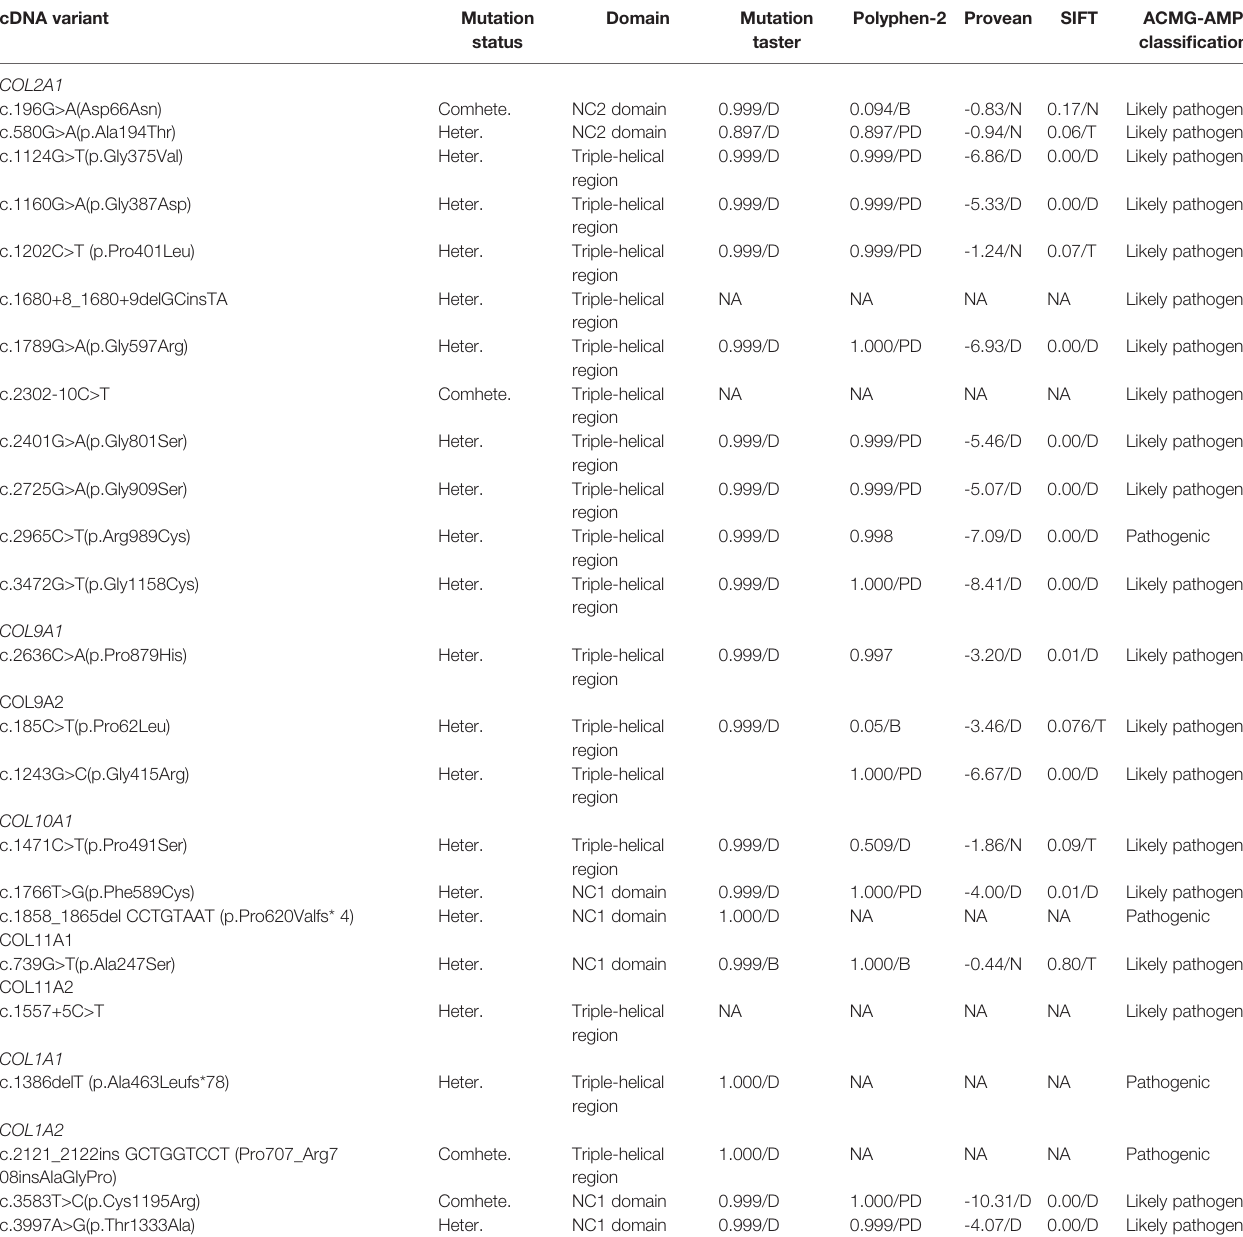
TABLE 1 | In silico analysis and ACMG/AMP classi fi cation of collagen gene identi fi ed